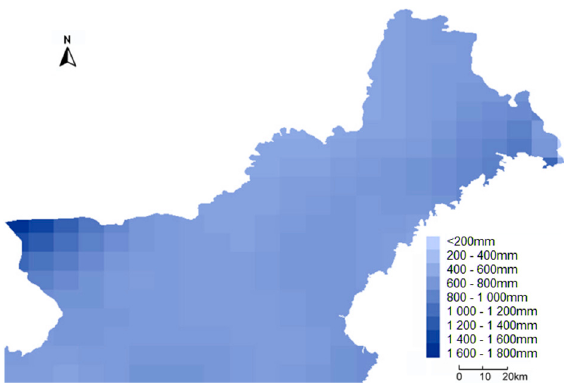
Figure 14. The map of average annual precipitation evaluated for 50 years in the Tumen River Basin (DPR Korea side).